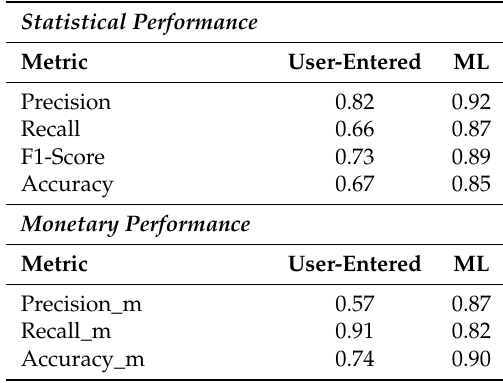
Figure 9. Test Set Results: ( a ) Statistical Performance: Actual outcome of all won (light green) and lost (light red) sales opportunities along with the corresponding predictions (solid green and red). ( b ) Monetary Performance: Cumulative contract value of won (light green) and lost (light red) sales opportunities along with the cumulative value of opportunities in each of the four classification scenarios (solid green and red). In both panels miss-matching colors indicates false classification. Table 5. Test Set Performance